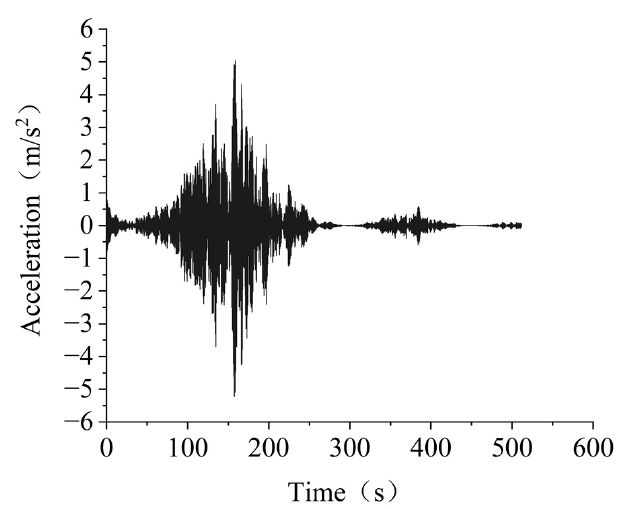
Figure 10. Acceleration diagram of transmission tower under downburst.